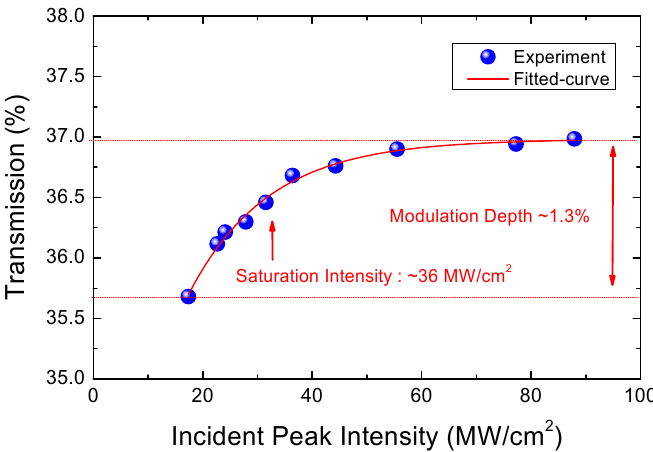
Figure 4. Measured nonlinear transmission of the Bi 2 Te 3 SA.